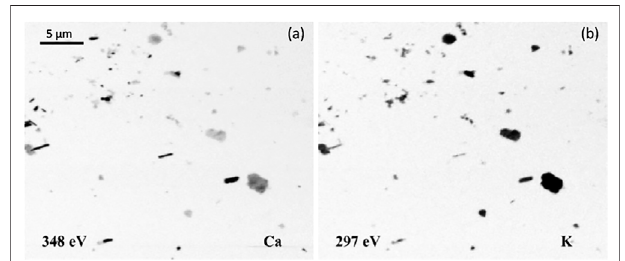
FIGURE 3 | STXM images show the morphology of sample #20 particles. (A,B) Snapshots measured at 348 and 297 eV, which are high absorption regions for Ca 2p and K 2p, respectively.